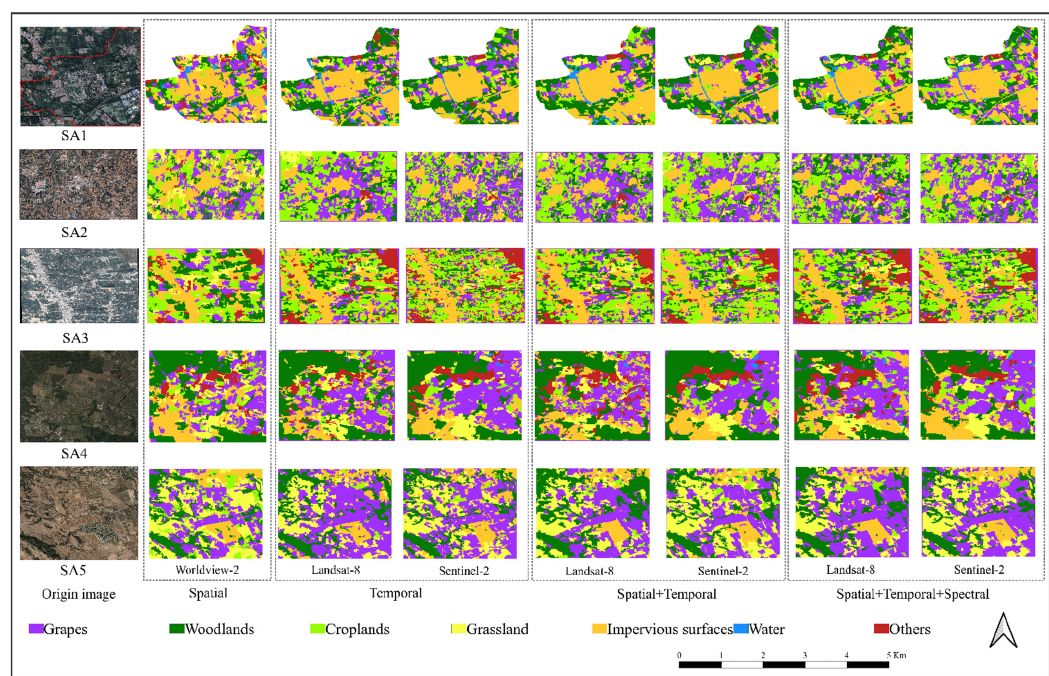
Figure 15. The VHR image and the classification maps of the five study areas using different classification inputs. The first dashed box: spatial features; The second dashed box: temporal features; The third dashed box: spatial + temporal features; The fourth dotted box: spatial + temporal + spectral features.